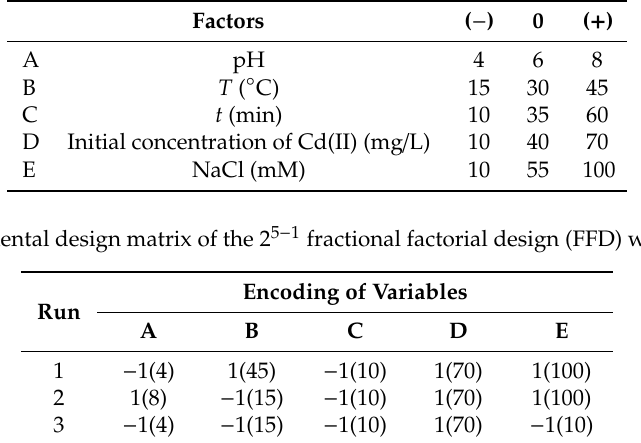
Table 1. Experimental factors and their values.